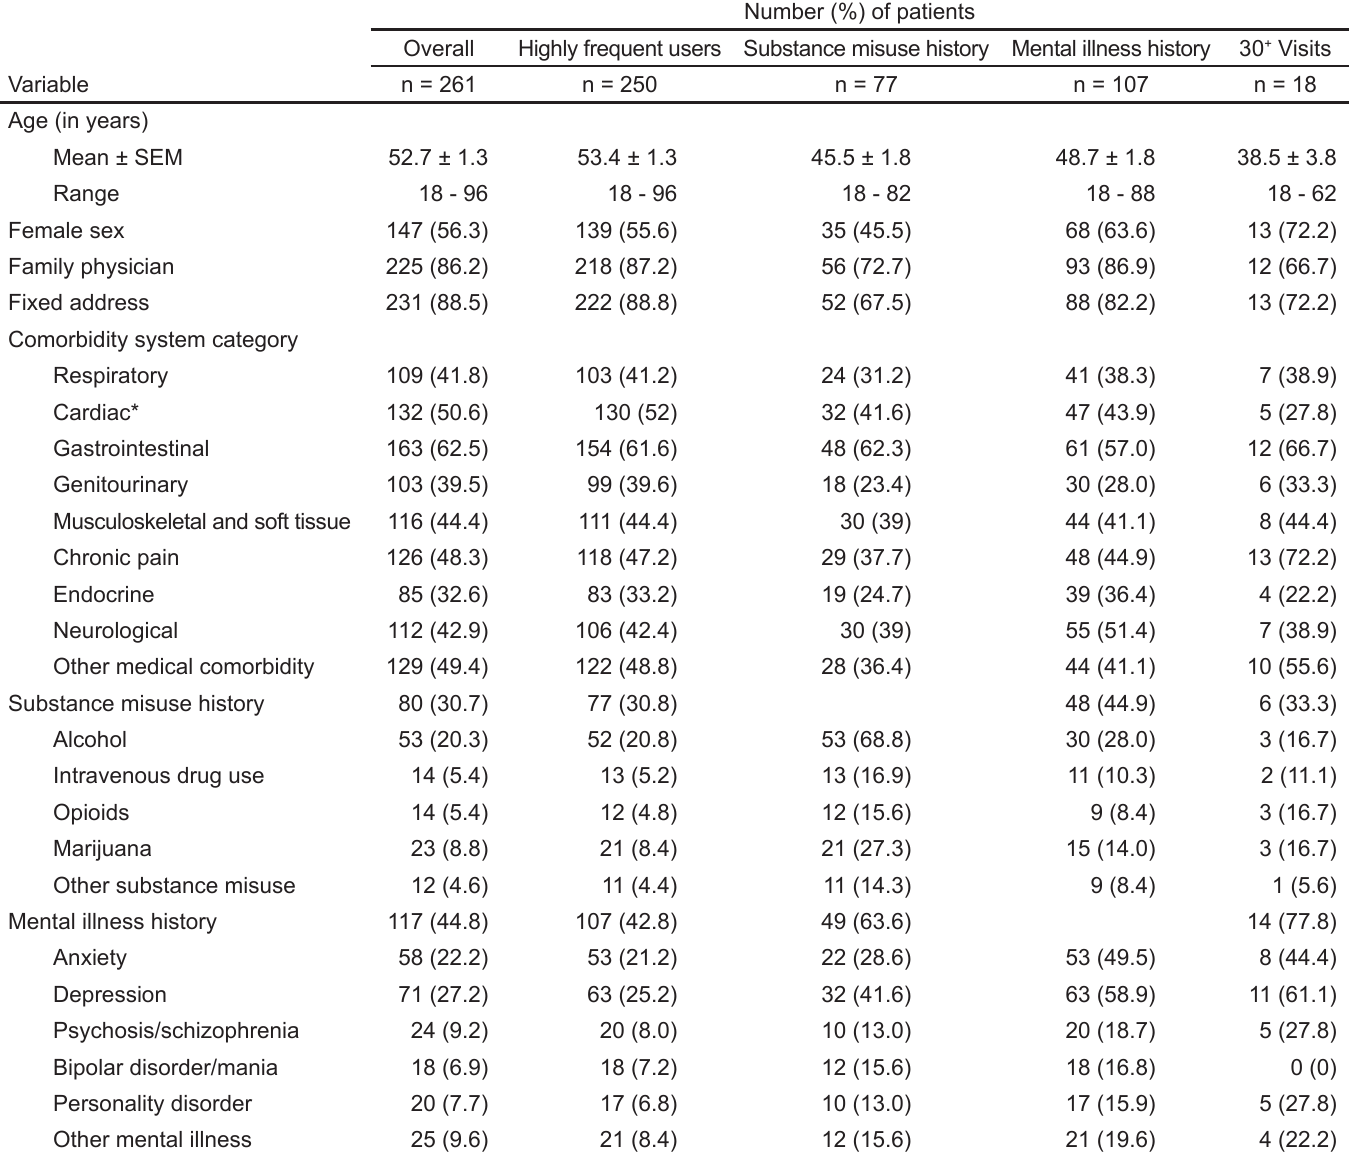
SEM , standard error of